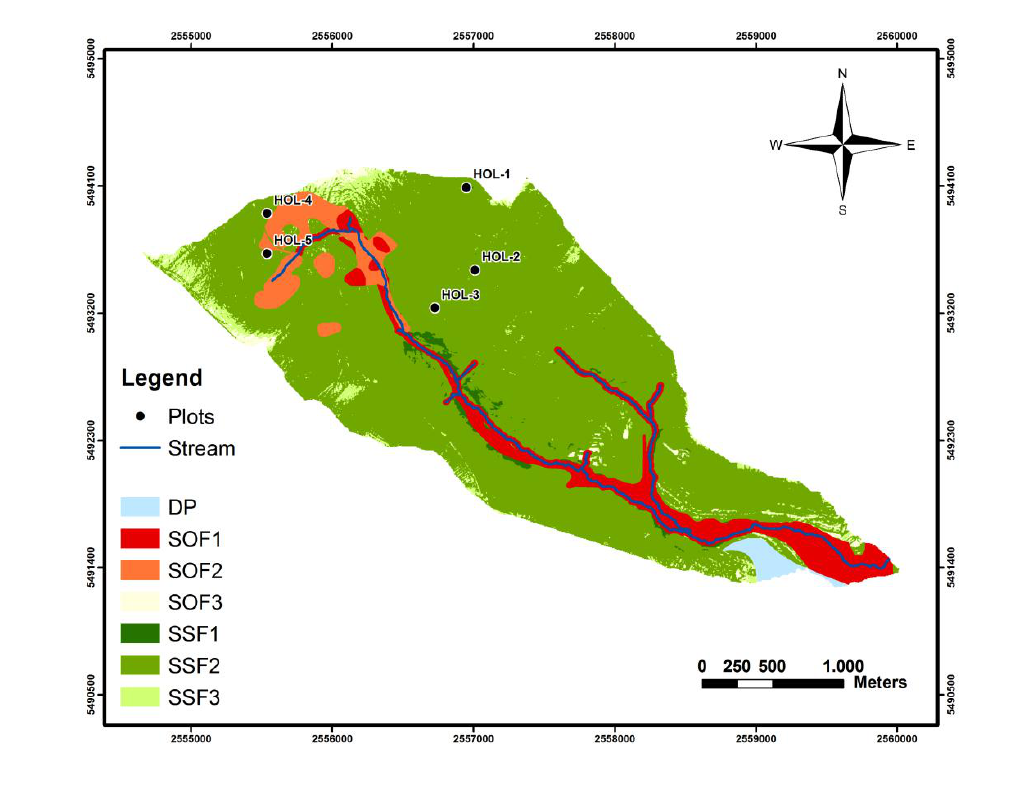
Figure 7. GIS-DRP map of the Holzbach catchment, Rhineland-Palatinate (error = lack of basic data).